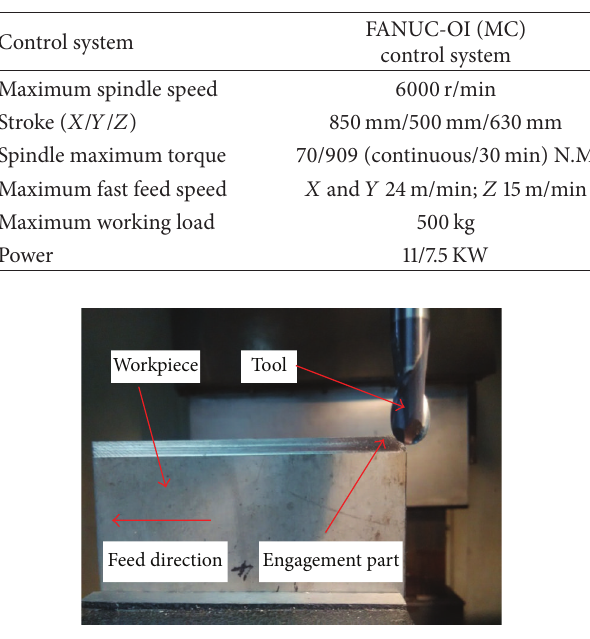
Figure 8: TH5650 vertical machining